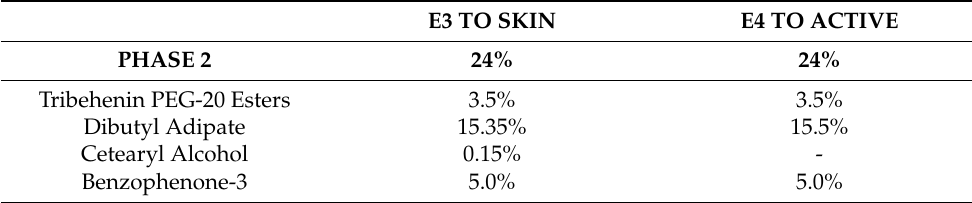
Table 10. Lipophilic phase of E3 TO SKIN emulsion and E4 TO ACTIVE emulsion.